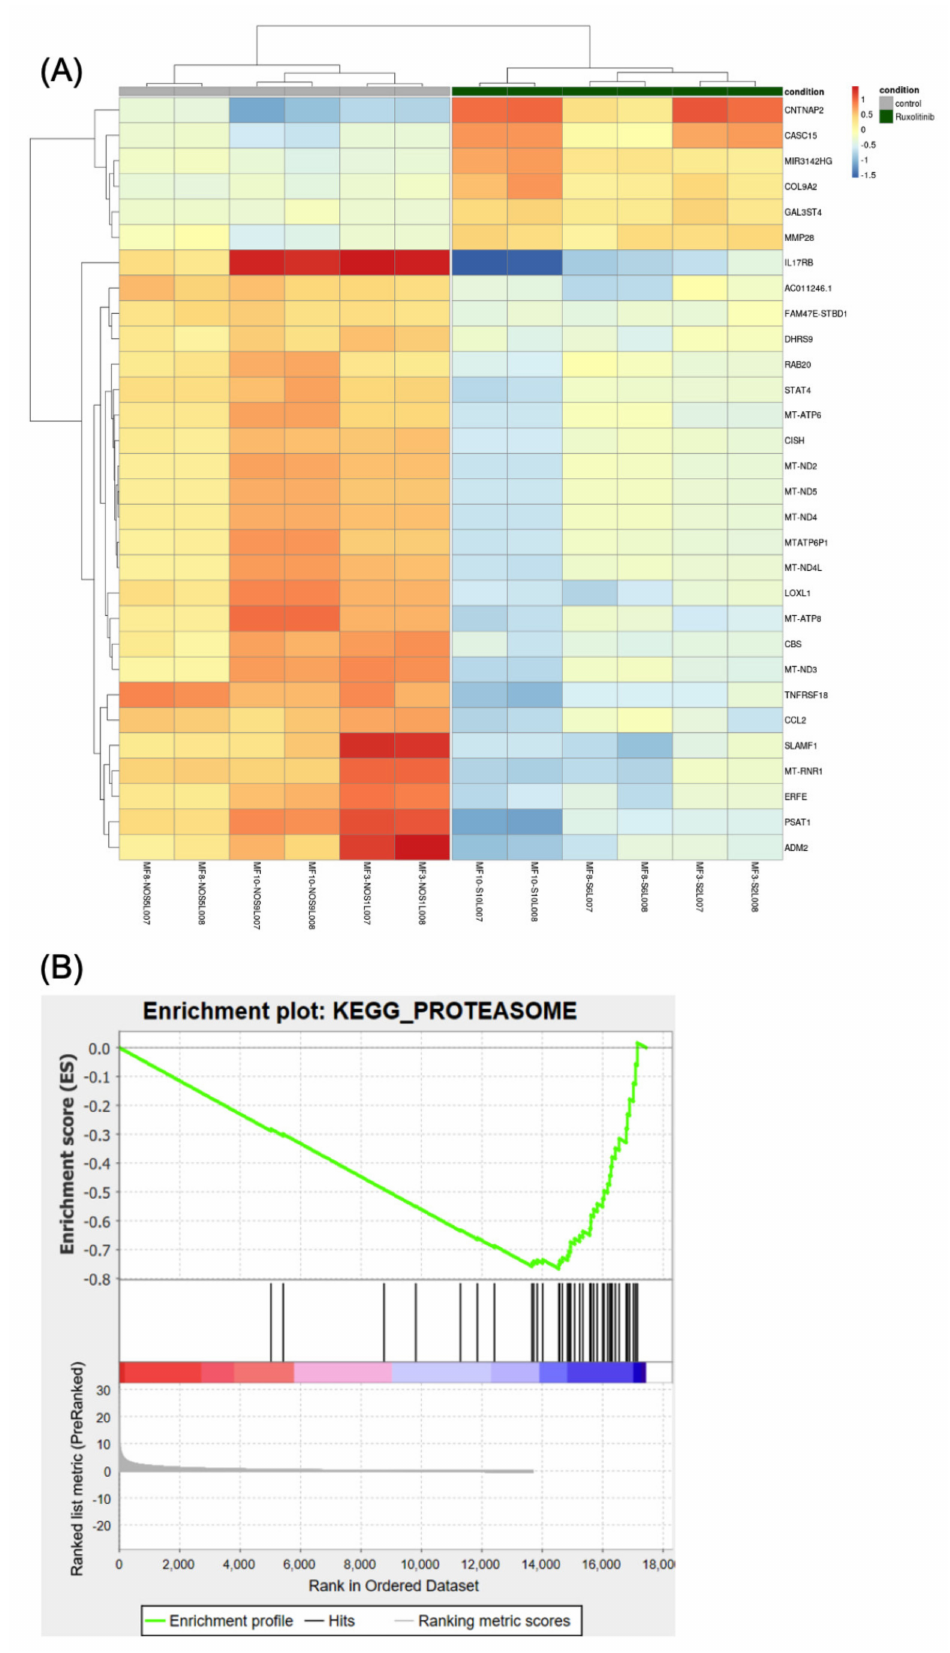
Figure 5. The differential expression analysis. ( A ) Heatmap showing the 30 most statistically relevant genes which are differentially expressed between the ruxolitinib-treated cells and the untreated